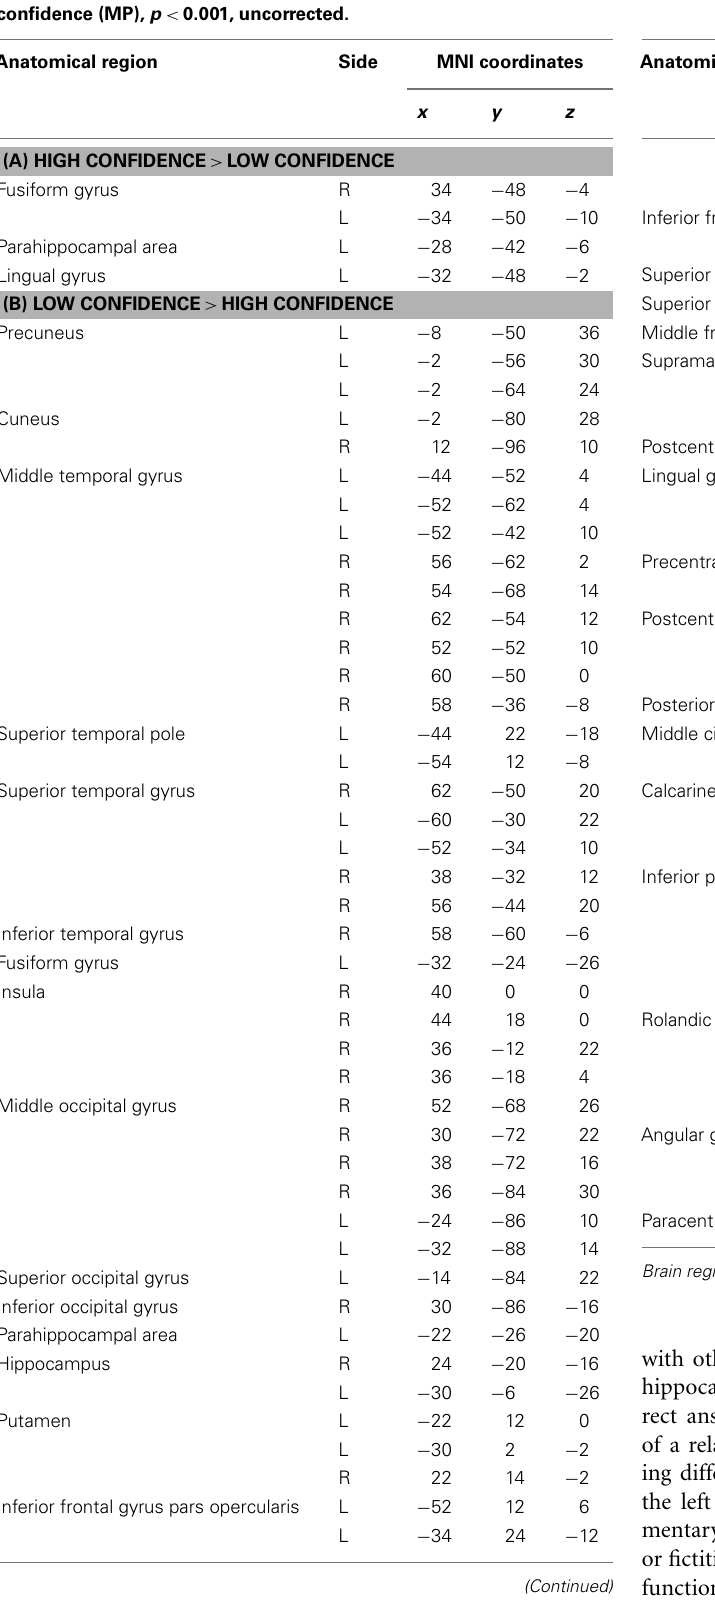
Table 2 | Group activations for the contrast between high versus low confidence (MP), p < 0.001,